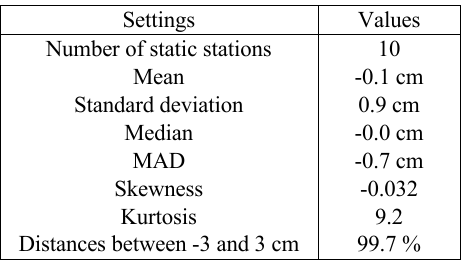
Table 6. Statistical result after segmenting the MMS cloud in 6 sections.